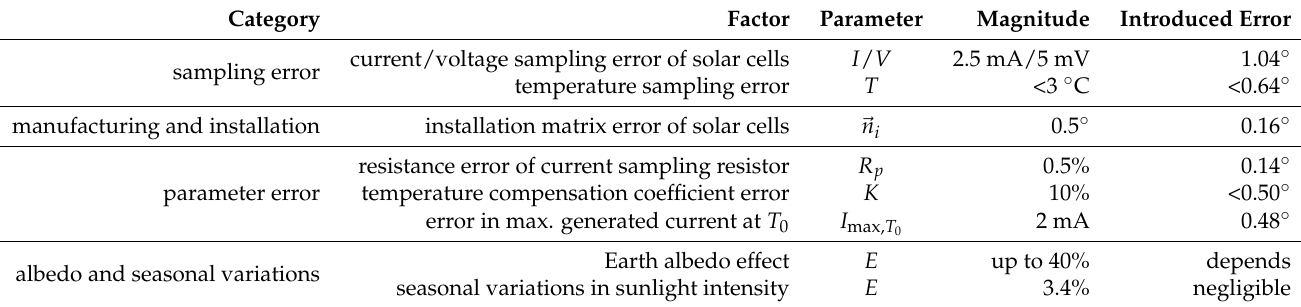
Table 2. Summary of factors that affect the on-orbit performance of IPSS.